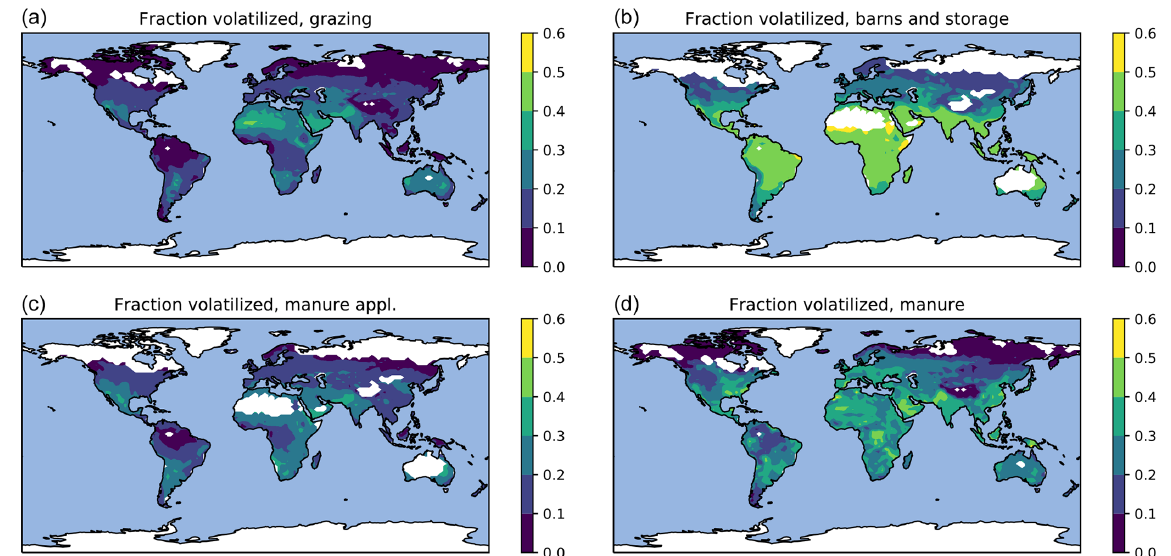
Figure 9. Fraction of manure N lost due to volatilization averaged for 2010–2015: grazing (a) , barns and storage (b) , manure application (c) , and all manure (d) . Table 1. Global and regional averages of volatilization losses in agricultural activities. The losses are given as fractions of total (organic and inorganic) manure or fertilizer nitrogen unless stated otherwise. The total volatilization loss for manure includes emissions from all individual processes normalized by the total manure N produced in the region. The average loss for synthetic fertilizers consists of emissions from urea and other fertilizers normalized by the total fertilizer N applied. Manure Synth. fertilizer Region Barns, Grazing b Spreading, Spreading, Total Urea Others stores a of total N c of TAN d